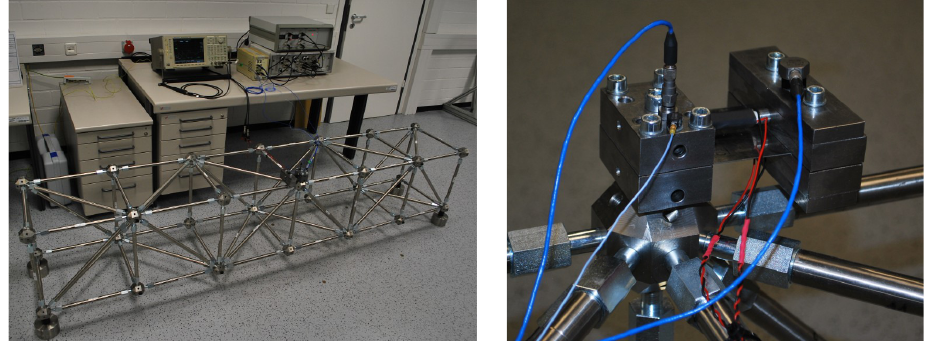
Figure 13. Test set up for the active control experiment ( left ) and detail of the actuator instrumentation ( right ).